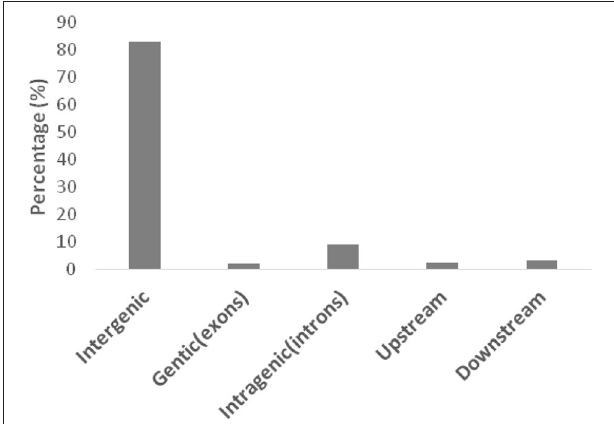
FIGURE 2 | Distribution of SNPs with the aa × bb segregation pattern on the basis of their locations in different genomic regions.